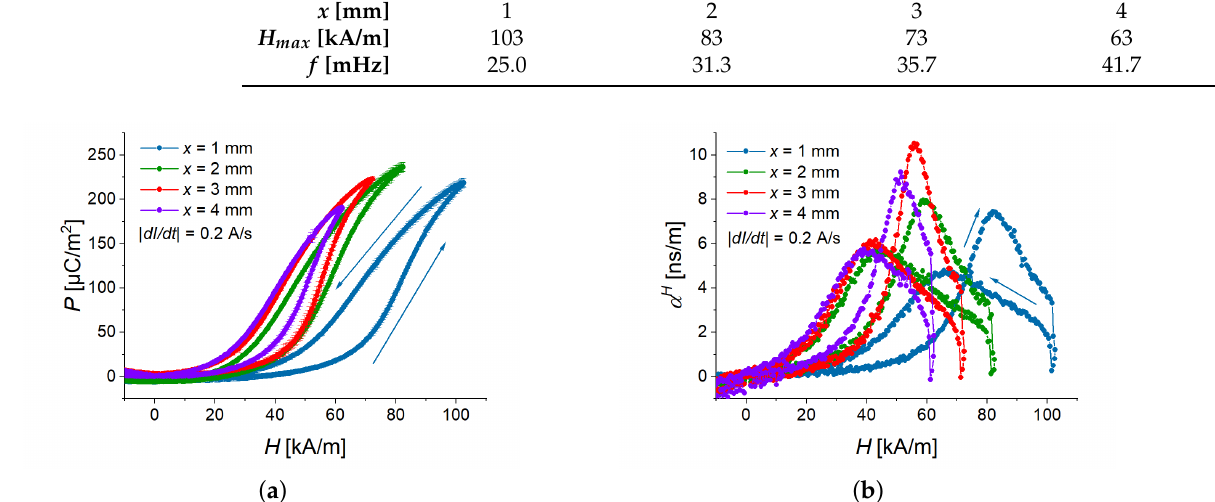
Figure 8. Field dependences of the electric polarization ( a ) and the ME coupling coefficient ( b ) for different thicknesses of MAE layer. The magnetic field slew rate is 12.2